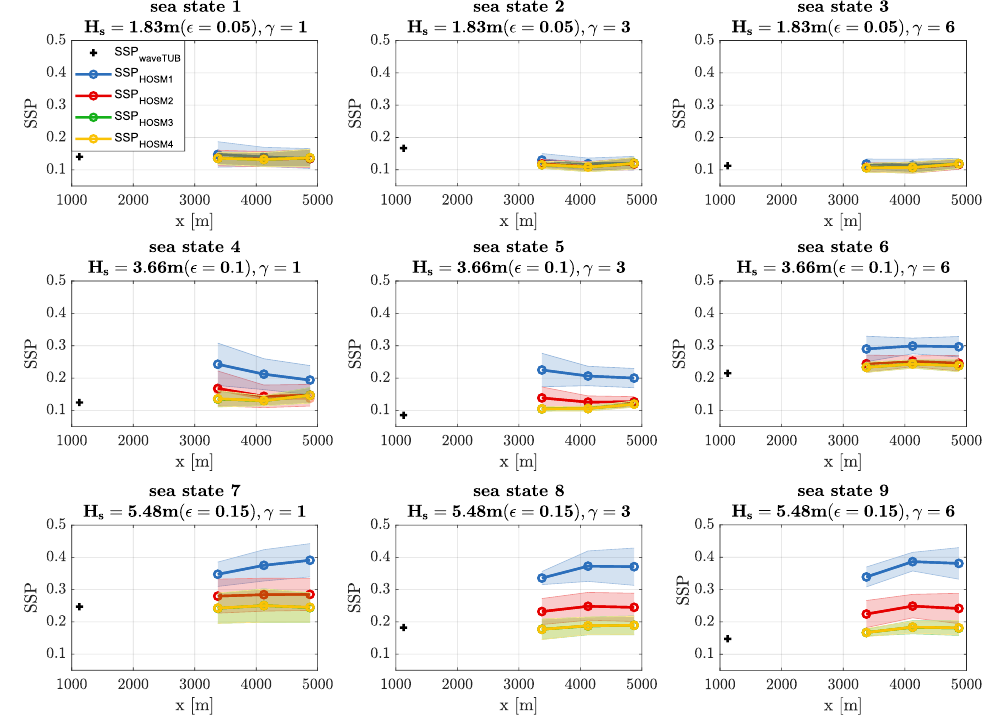
Figure 6. Experimental results: SSP for the investigated sea states (see Table 2) at the three wave gauges for the HOSM1 (blue curves), HOSM2 (red curves), HOSM3 (green curves), and HOSM4 (yellow curves) simulations in the space domain. The dots on the curves illustrate the positions of the three wave gauges. The transparent areas around the respective curves (with the same color) represent the corresponding variance, and the SSP of the waveTUB input snapshots is illustrated as a black